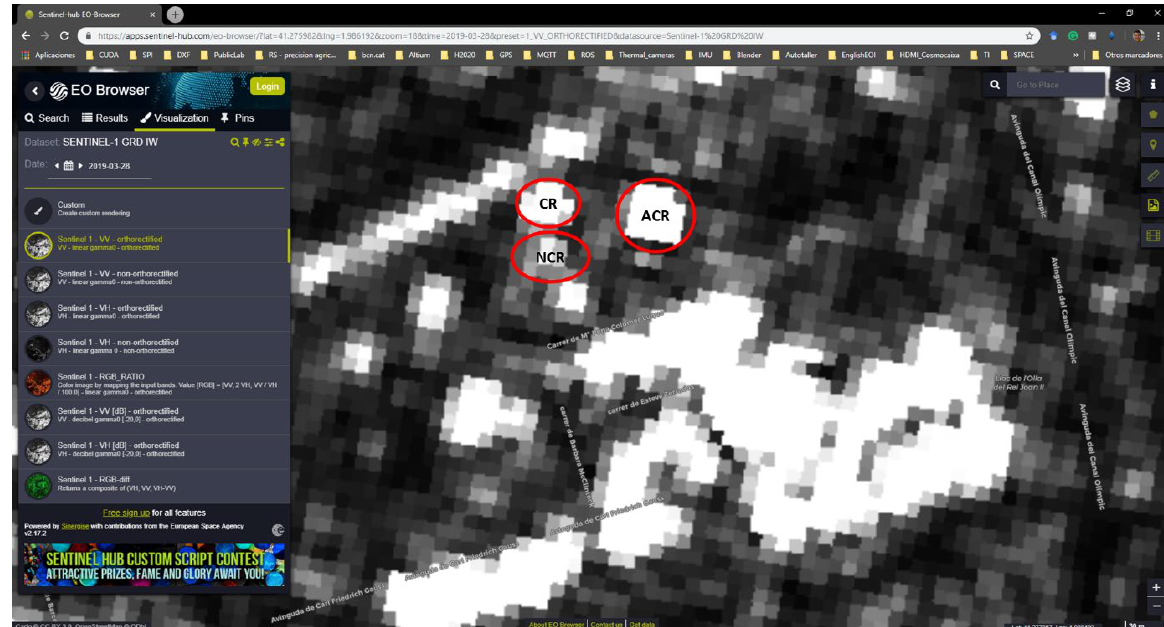
Figure 5. Amplitude Sentinel-1 image of the Parc Mediterrani de la Tecnologia. The red circles indicate the response of an AR (ACR), a passive reflector (CR) and a natural reflector